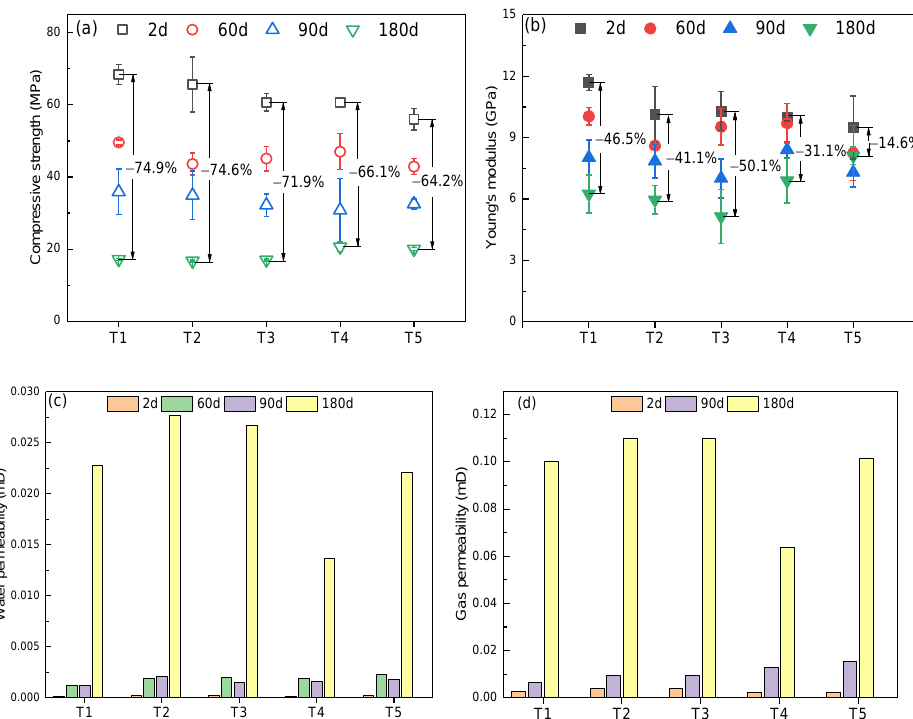
Figure 2. Long-term macroscopic property of T1 to T5 cured under 200 °C and 50 MPa showed decreasing strength and modulus as well as increasing water/gas permeability from 2 to 180 d: ( a ) compressive strength; ( b ) Young’s modulus; ( c ) water permeability; ( d ) gas permeability.